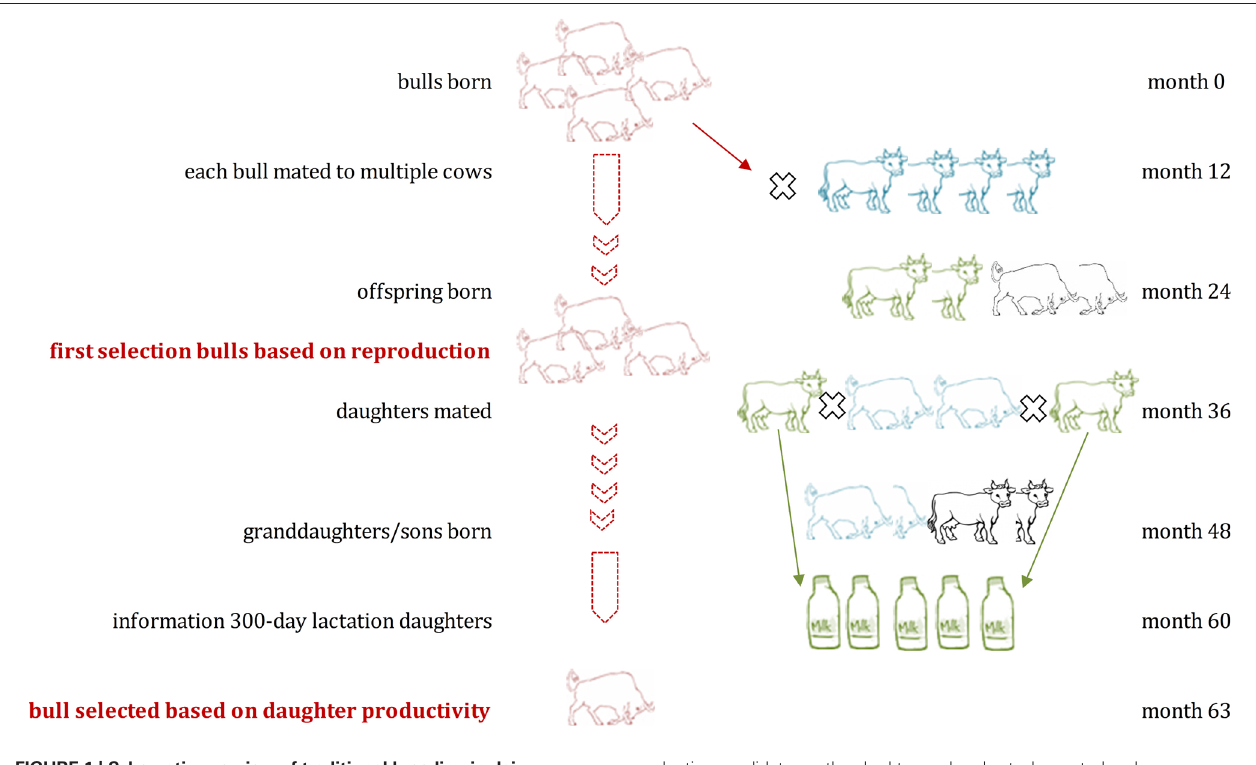
FIGURE 1 | Schematic overview of traditional breeding in dairy cattle: Selection candidates (bulls) are born and mated to multiple cows at around 12 months of age. In month 60 the first phenotypic recordings (milk yields) are available from the daughters of the